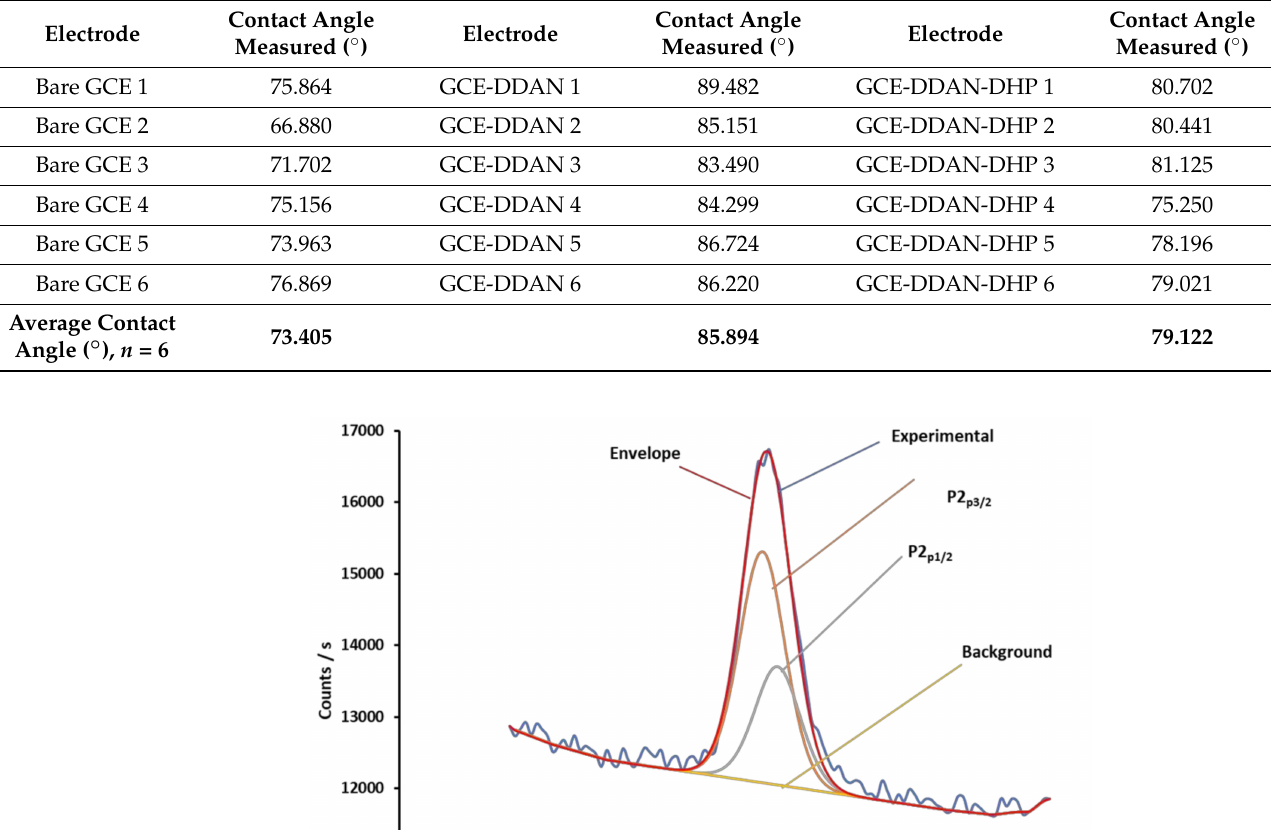
Table 1. Contact angle measurements of the bare GCEs, GCEs modified with the DDAN layer, and the GCEs with the HBLM (DDAN + DHP) with the average contact angle values obtained from six independent GCE surfaces ( n = 6).